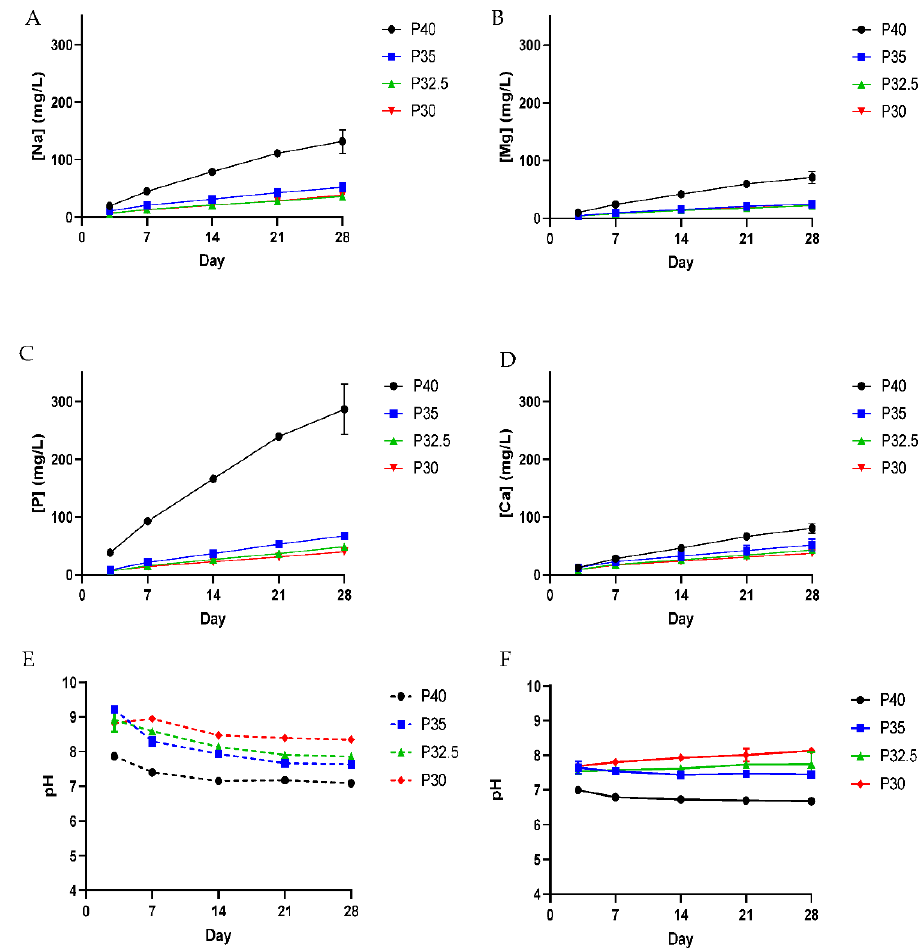
Figure 6. Cumulative ion release profile of ( A ) sodium, ( B ) Magnesium, ( C ) phosphorous and ( D ) calcium from P40 (black), P35 (blue), P32.5 PMs (green) and P30 (red) porous microspheres in milli-Q water over 28 days at 37 °C. ( E ) pH change of milli-Q water as a function of immersion time for porous and ( F ) solid microspheres.